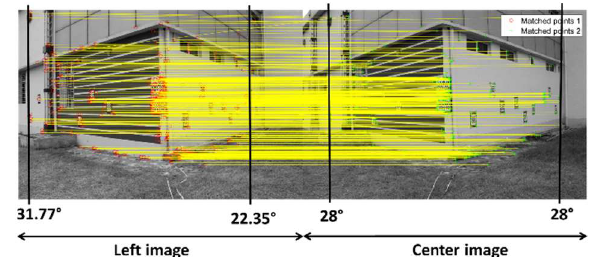
Figure 10. Matched keypoints between the left and center images ( ψ = 39.4286º, ψ = 45º ) acquired at 6m. Matching keypoints in two images are connected by yellow